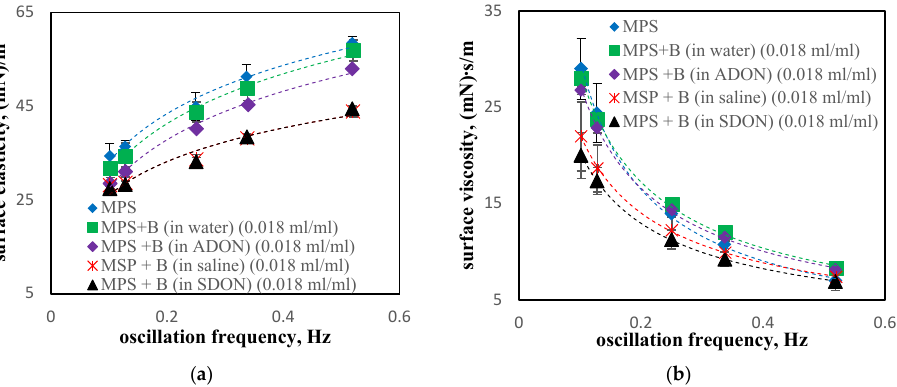
Figure 9. Dilatational surface elasticity ( a ) and viscosity ( b ) in the presence of the drug containing budesonide (B) diluted in water, saline, ADON, or SDON. The surface viscosity of MPS is only slightly changed at f > 0.25 Hz; however it is decreased by budesonide medicine (in various solvents) at f = 0.1–0.15 Hz (Figure 9b). Similar to elasticity, the effect of oxygen NBs is small compared to the effect caused by the drug. The presence of NaCl in the solvent (physiological saline or SDON) results in the lowest values of surface viscosity, which confirms the role of electrolytes and the synergic effects of NBs and ions.